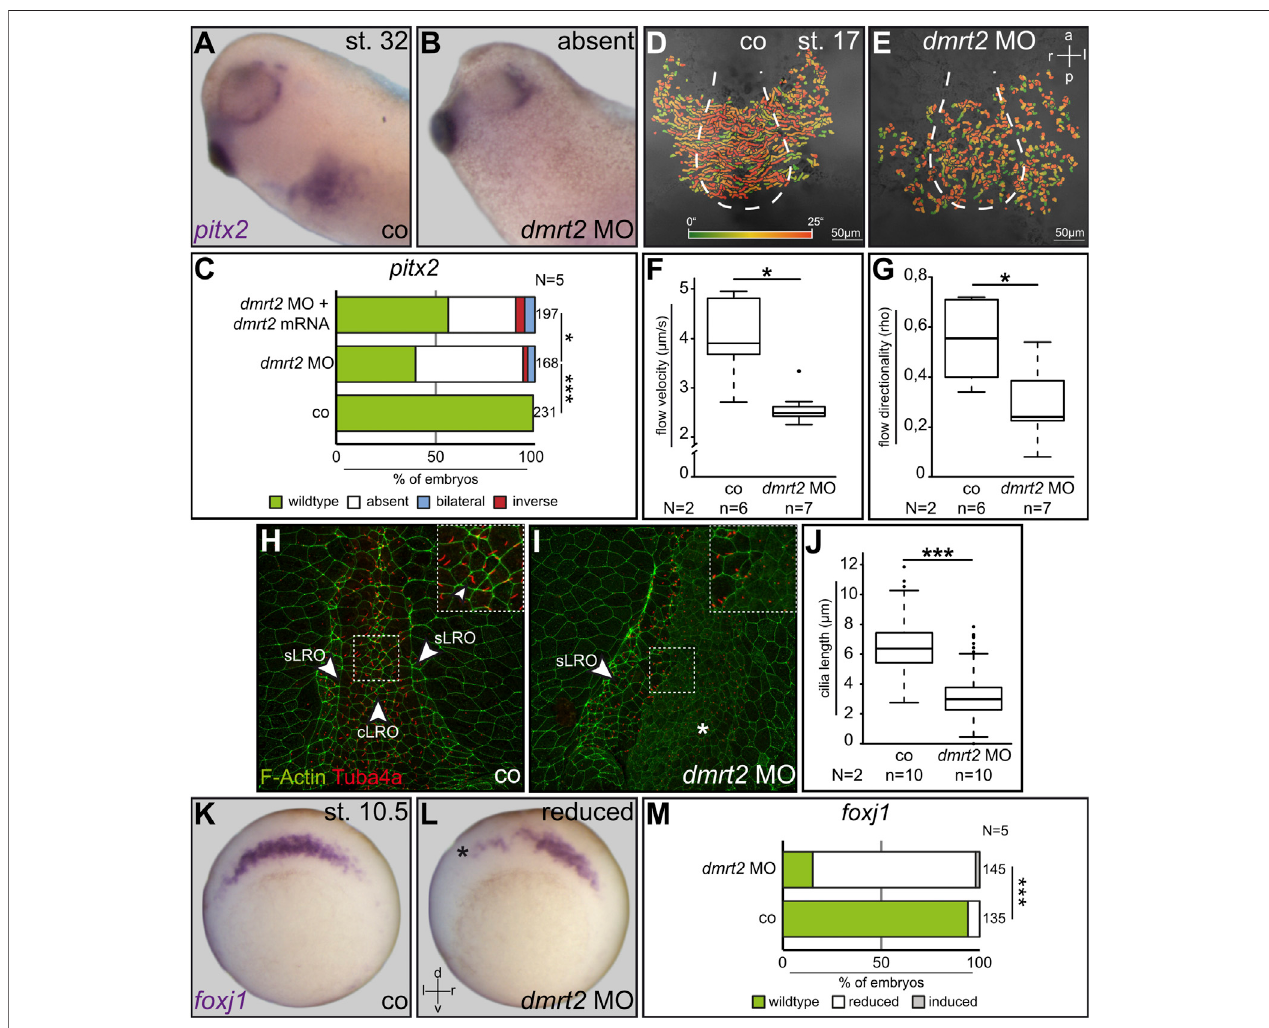
FIGURE 1| Dmrt2 is required for left-right development. Expression of the LR marker pitx2 in the left LPM was lost in 60%of specimens after left-sided injection of dmrt2 MO (A – C) . Co-injection of full-length dmrt2 mRNA statistically signi fi cantly restored pitx2 asymmetry (C) . Leftward fl uid fl ow in controls and bilaterally injected dmrt2 morphants which was perturbed (D,E) in velocity (F) and directionality (G) . LROs of controls and dmrt2 knockdown embryos were analyzed by immuno fl uorescence, detecting F-actin (green) and Tuba4a [red; (H,I) ]. Compared to controls, cilia were statistically signi fi cantly shorter in morphants (G) . Note enhanced F-actin signals in lateral sensory LRO cells [ (H) , sLRO] compared to fl ow-generating central LRO cells [ (H) , cLRO]. Enhanced F-actin signals were lost on the dmrt2 MO-injected side (I) . SM expression of foxj1 in wildtype embryos (K) was diminished by dmrt2 loss of function (L,M) . Numbers (n) in (C,F,G,J,M) represent analyzed specimens. N represents the number of independent experiments. Statistical analyses were done with one-sided Pearson ’ s chi-square test (C,J,M) or Wilcoxon-Match-Pair test (F,G) ; * signi fi cant p < 0.05; ***, very highly signi fi cant p < 0.001. Asterisks mark injected sides; a = anterior; co = control; cLRO = central left- right organizer; l = left; p = posterior; r = right; sLRO = sensory left-right organizer.